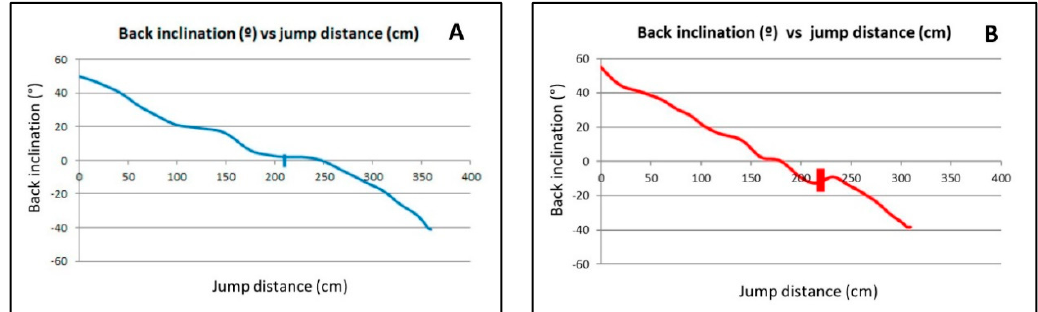
Figure 3. Graphic representation of the jump height (cm, y -axis) vs. jump distance travelled (cm, x - axis) of two agility dogs of different jumping abilities and competing at different levels. ( A ) dog number 1 of A group (excellent jumpers, competing in third and greater level of competition). ( B ) dog number 5, ranked as the worst jumper among all the dogs in group B (less-skilled jumpers, competing in second and lesser level of competition). Vertical line represents the 60-cm hurdle.